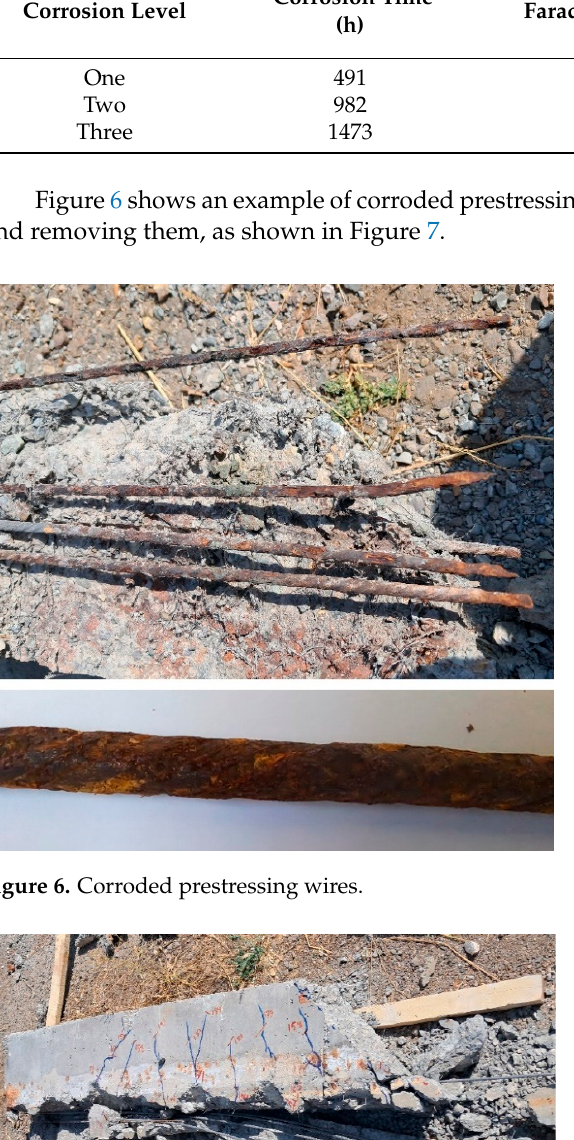
Figure 5. Schematic view of the corrosion test setup. Figure 4. Accelerated corrosion of the prestressed concrete beams. Table 5. Corrosion time and actual corrosion rate for the accelerated corrosion process.